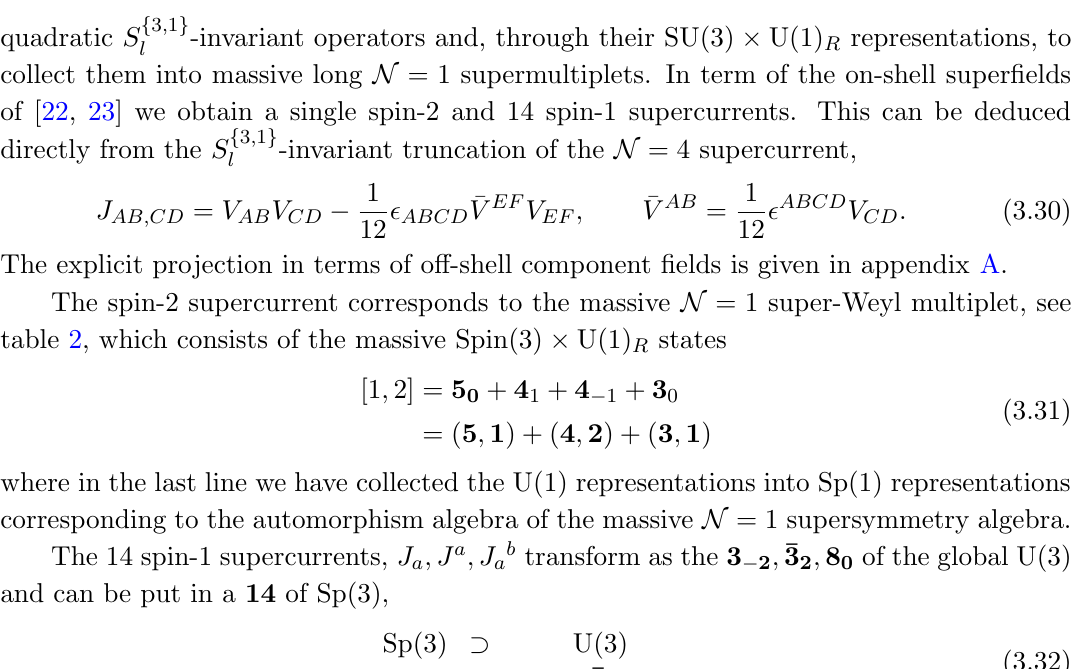
Table 4 . The charges carried by the component (cid:12)elds (in terms of on-shell (cid:12)eld strengths) of the N = 4 super Yang-Mills multiplet under the S f 3 ; 1 g invariant SU(3) (cid:2) U(1) R (cid:26) SU(4) (cid:13)avour/R-symmetry subgroup. Note, for k = 3 both F and (cid:21) 4 are S f 3 ; 1 g